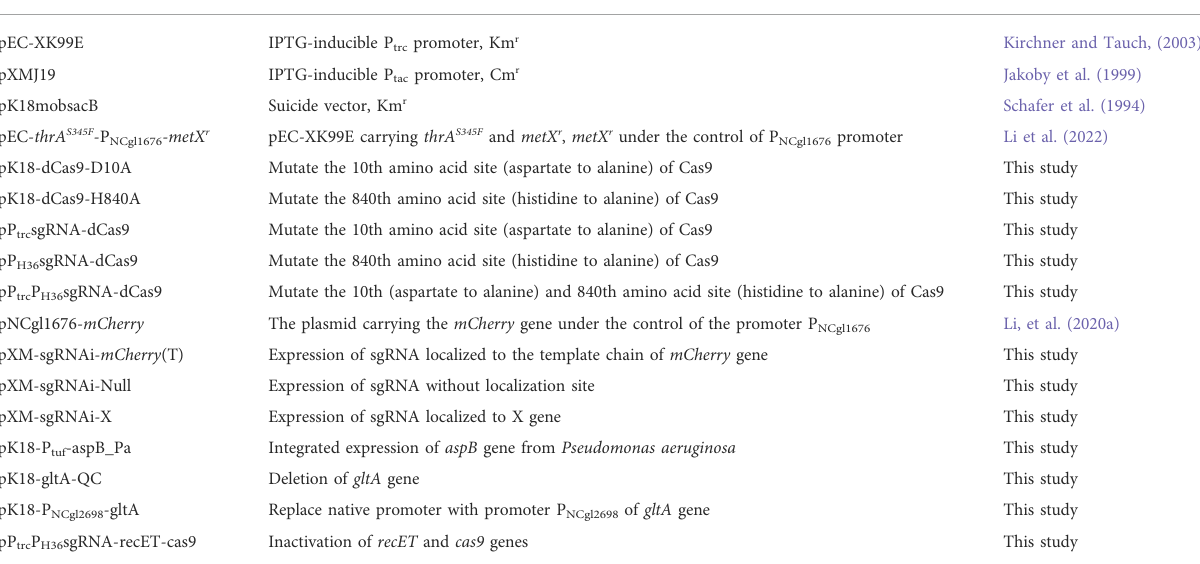
TABLE 2 Plasmids used in this